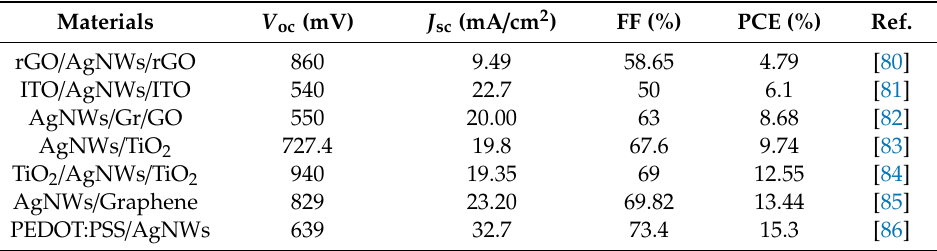
Table 3. Performance of AgNW-based solar cells.